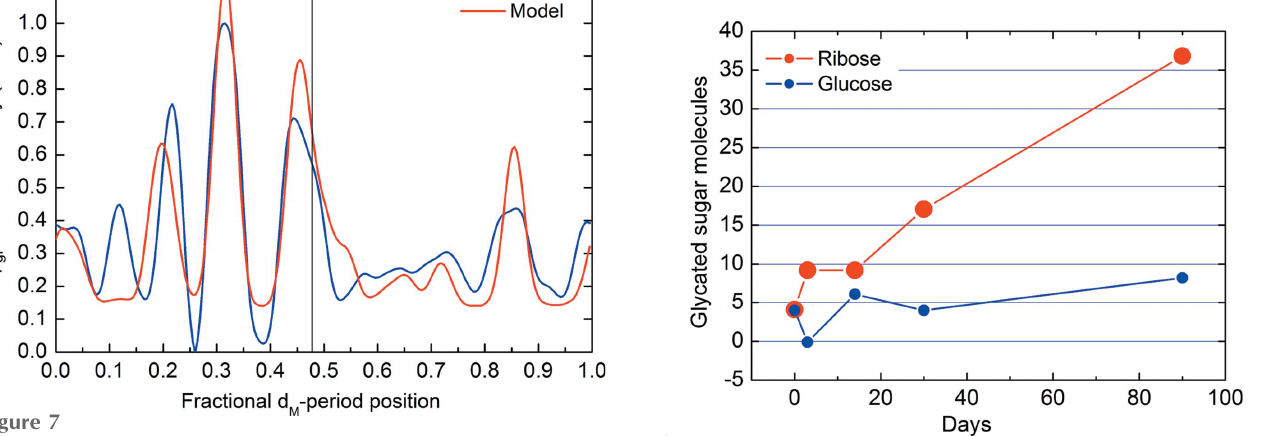
Figure 8 Number of sugar molecules involved in the glycation of one collagen repeat unit as predicted by Equation (S9) for a solution of either 40 mg ml (cid:2) 1 ribose (red) or glucose (blue), in water.